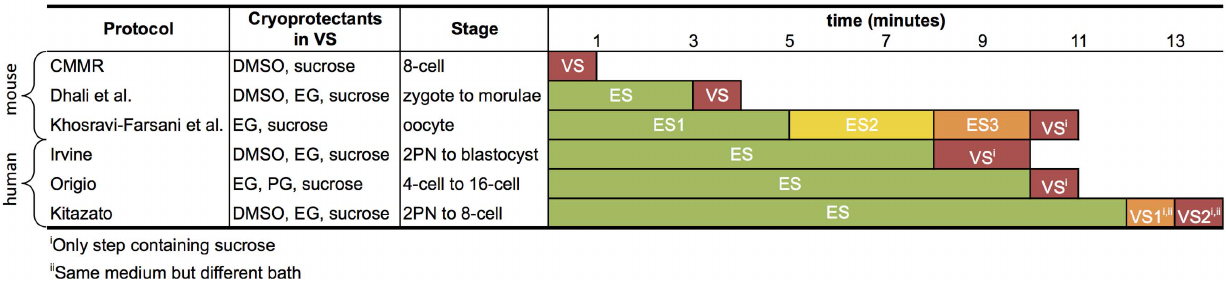
Figure 6. Comparisons of mouse and human vitrification protocols [28,29,42–47] . For those protocols that specify a timing range, the average value is used.